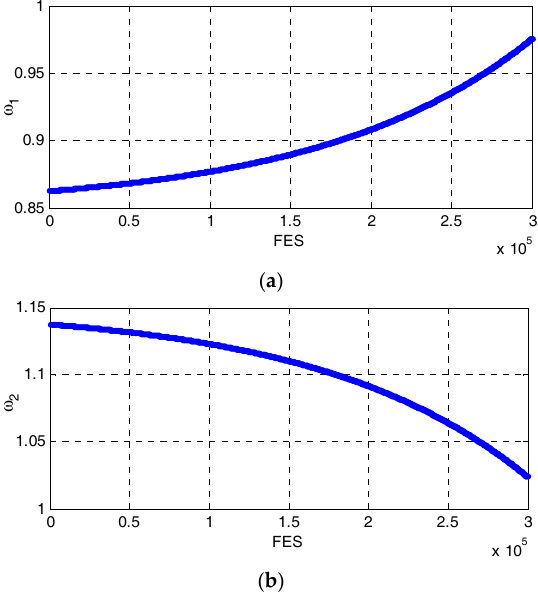
Figure 1. Variation curves of inertia factors. ( a ) the variation of ω 1 ; ( b ) the variation of ω 2 .